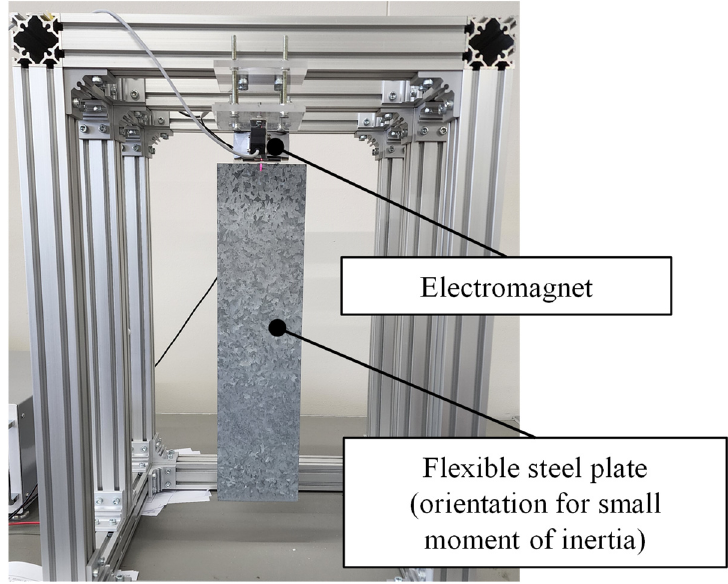
Figure 1. Proposed magnetic levitation system.